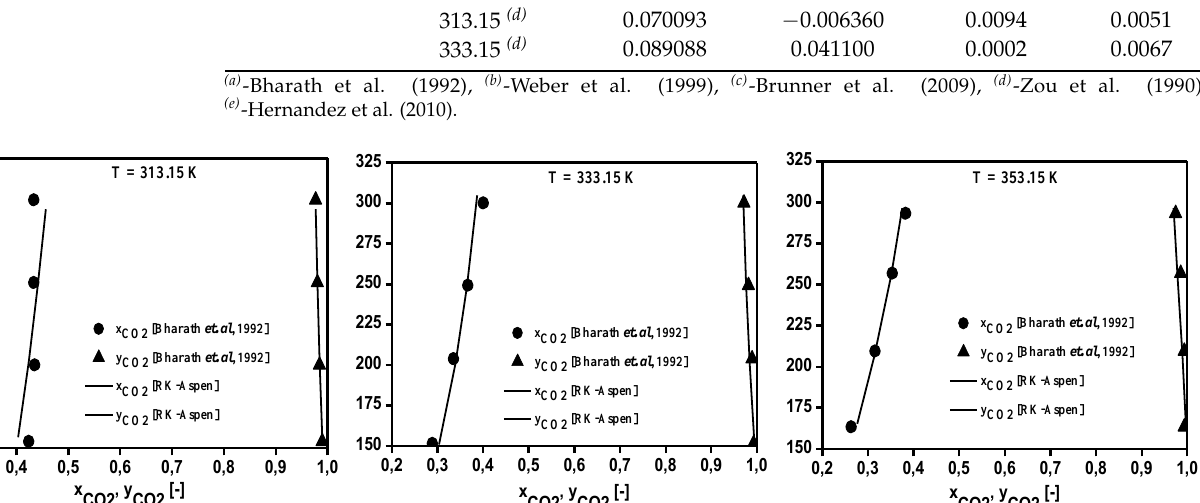
Molecules 2021 , 26 , x FOR PEER REVIEW